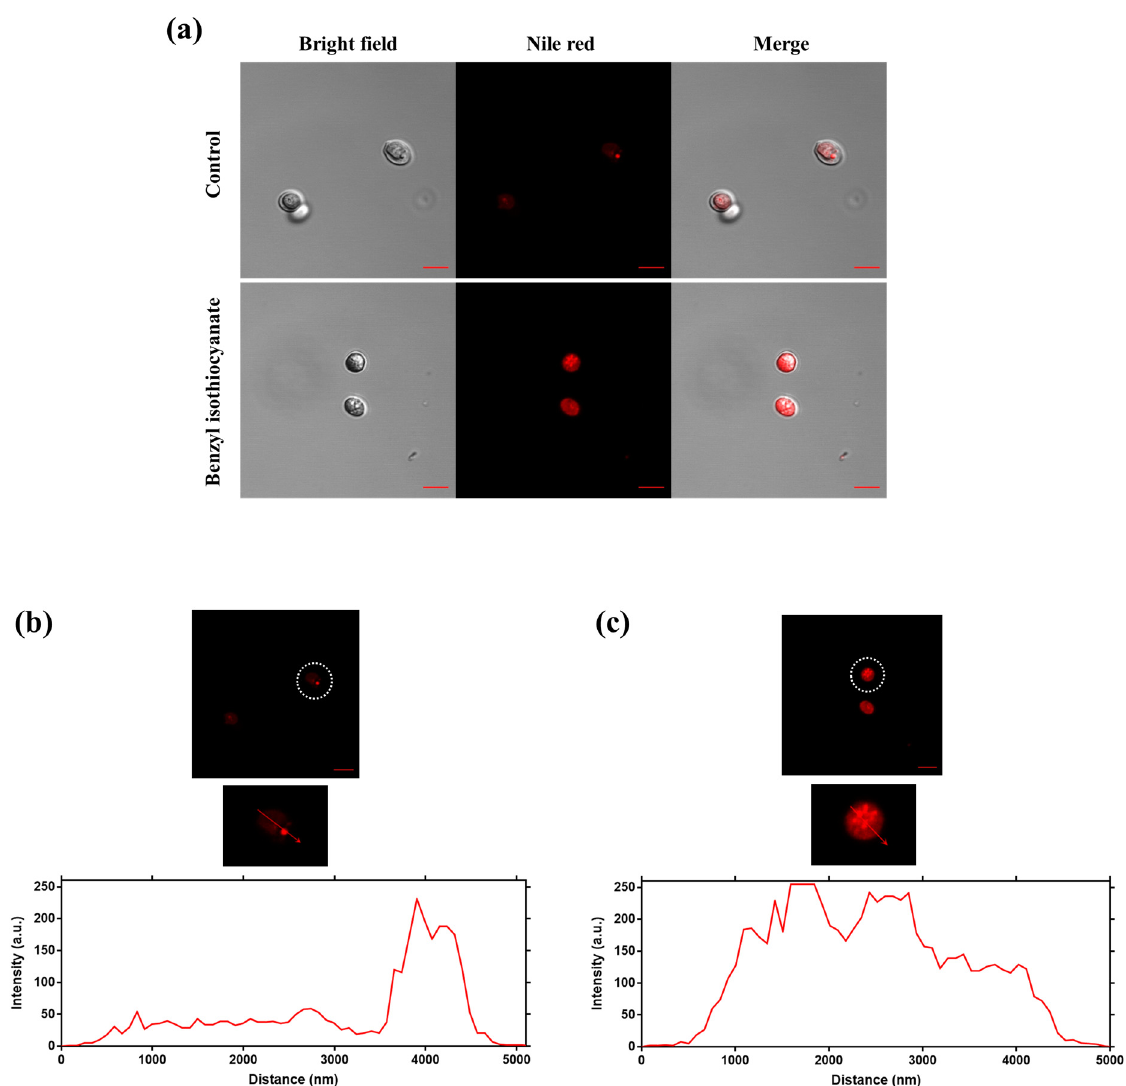
Figure 4. Confocal micrographs and fluorescence intensity profiles of benzyl isothiocyanate-loaded plasmolyzed yeast cells. The top row of ( a ) represents the bright field, Nile Red, and merge images of the control (plasmolyzed yeast cell). The bottom row of ( a ) represents the bright field, Nile Red, and merge images of benzyl isothiocyanate-loaded plasmolyzed yeast cells. Line-scan profiles of fluorescence intensity for the control (plasmolyzed yeast cell) and benzyl isothiocyanate-loaded plasmolyzed yeast cells are shown in ( b ) and ( c ), respectively.